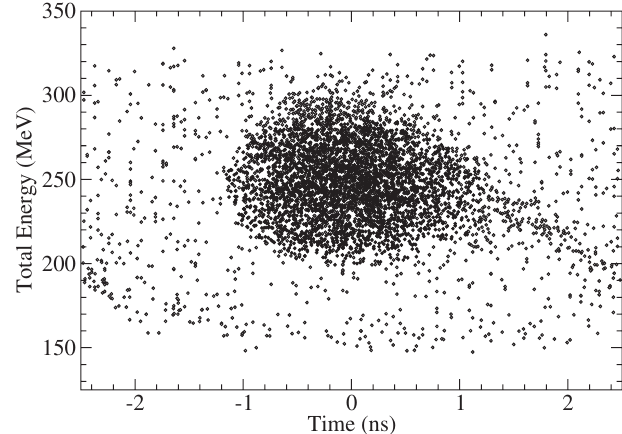
FIG. 15. (Color) The muons per incident proton on target into the accelerator normalized transverse acceptance of A 30 mm rad and normalized longitudinal acceptance of A